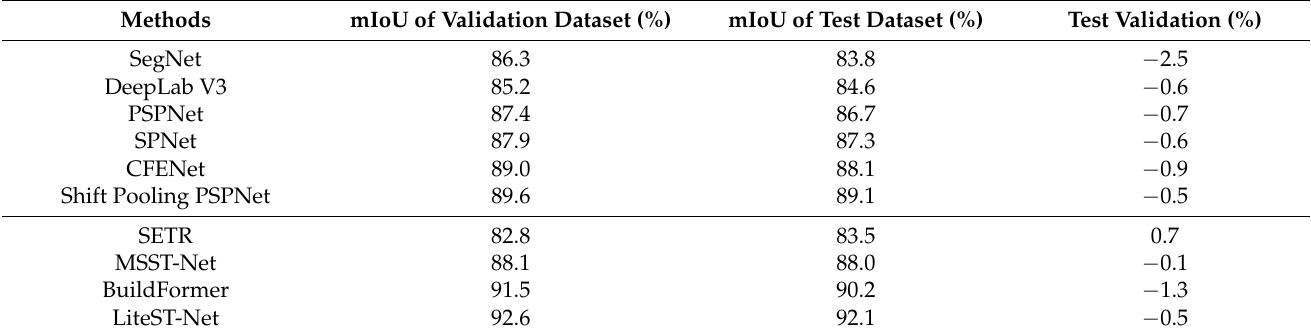
Table 5. mIoU of all networks on validation and test dataset of the WHU building